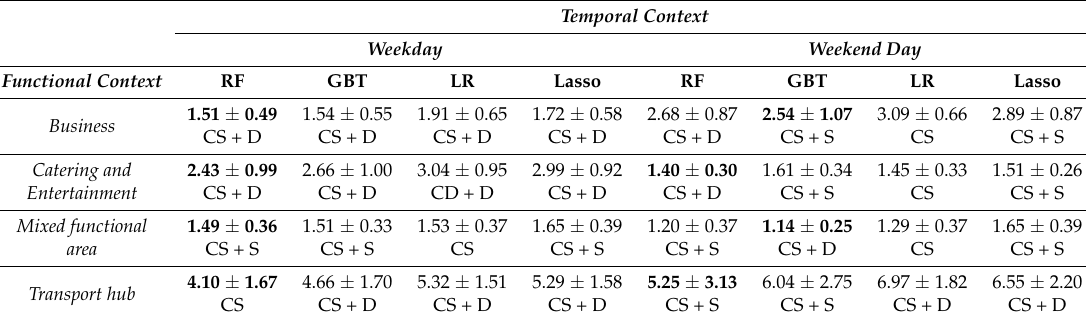
Table 5. Comparison between ML-based algorithms in terms of MAE (avg ± std).